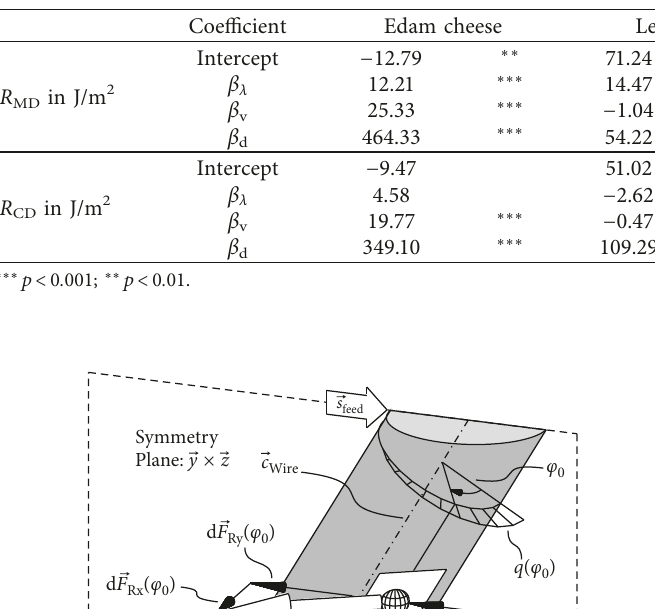
Table 1: Model influences with significance